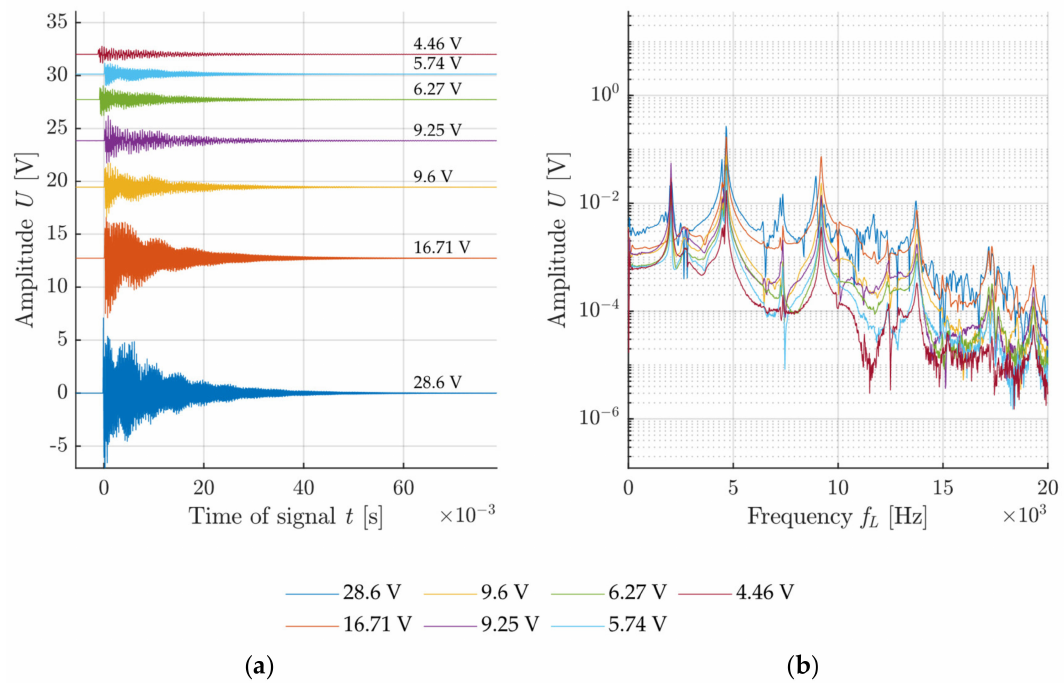
Figure 11. Example of impact with a hammer with a blunt tip without a handle: ( a ) Signals from the sensor attached to the test specimen with rising impacting force; ( b ) frequency spectrum of recorded